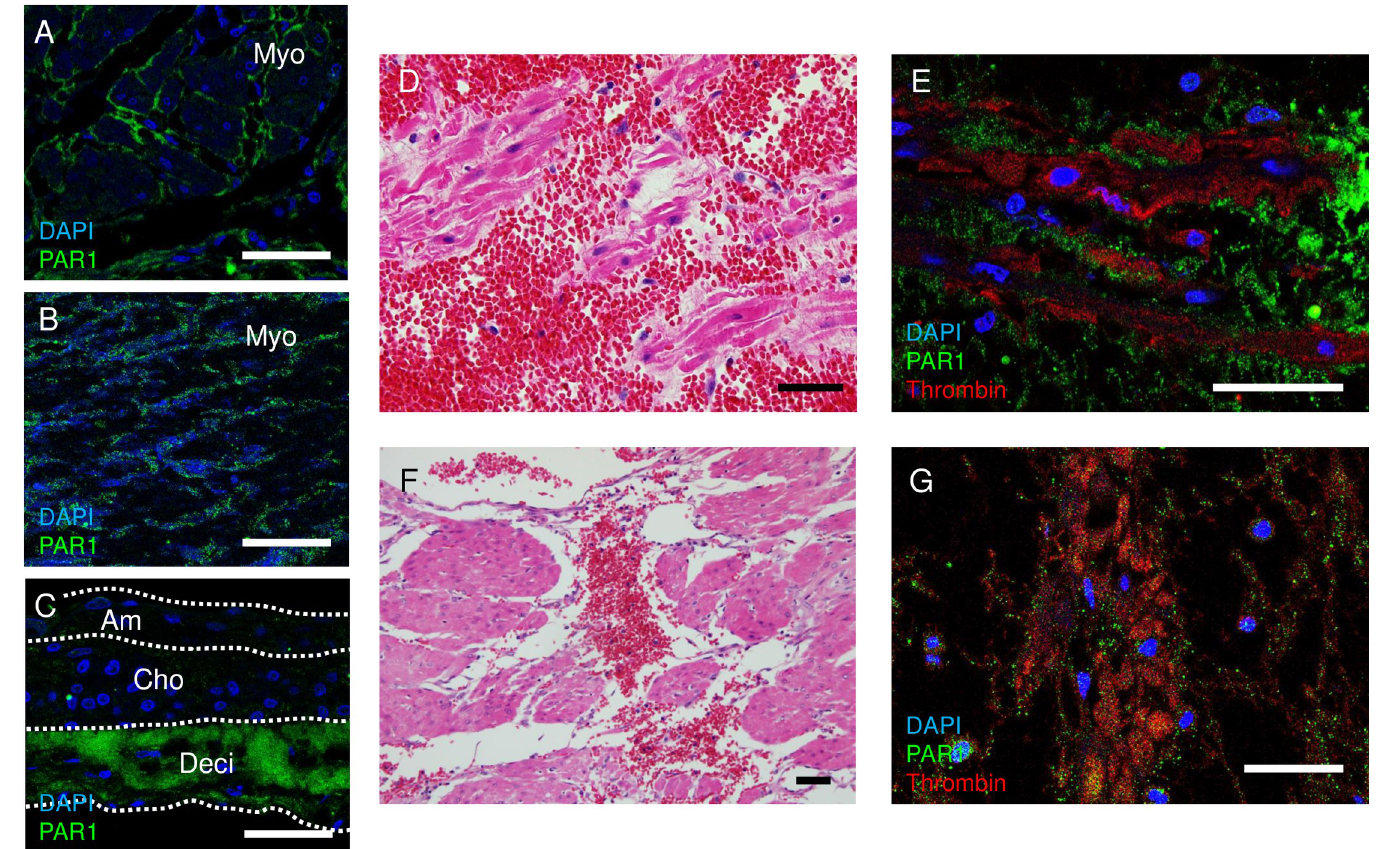
Fig 1. Thrombin receptor, protease-activated receptor 1 (PAR1), is expressed in human myometrium. (A-C) Immunofluorescence of PAR1 (green) in myometrium from a pregnant woman (A) , non-pregnant woman ( B ), and fetal membrane (C) . Nuclei were stained with DAPI (blue). Am, amnion, Cho, chorion, Deci, decidua. (D-G) Localization of hemorrhage, thrombin, and PAR1 in placental abruption at 25 weeks of gestation (D and E) , and 33 weeks gestation (F and G) resulting in disseminated intravascular coagulopathy and uterine bleeding requiring hysterectomy for hemostasis. (D and F) Hematoxylin and eosin staining of the myometrium adjacent to the placenta. Note that hemorrhage infiltrated the myometrium. Bars, 50 μ m. (E and G) Immunofluorescence of PAR1 (green), thrombin (red), and DAPI (blue) at the same location of (A) . Bars, 50 μ m.